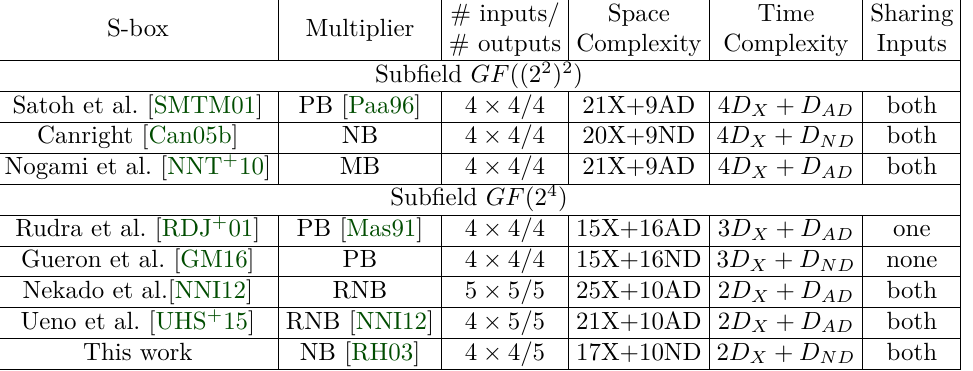
Table 6: Multipliers used in different AES S-boxes with their sharing capability between different multipliers (X=XOR, ND=NAND,